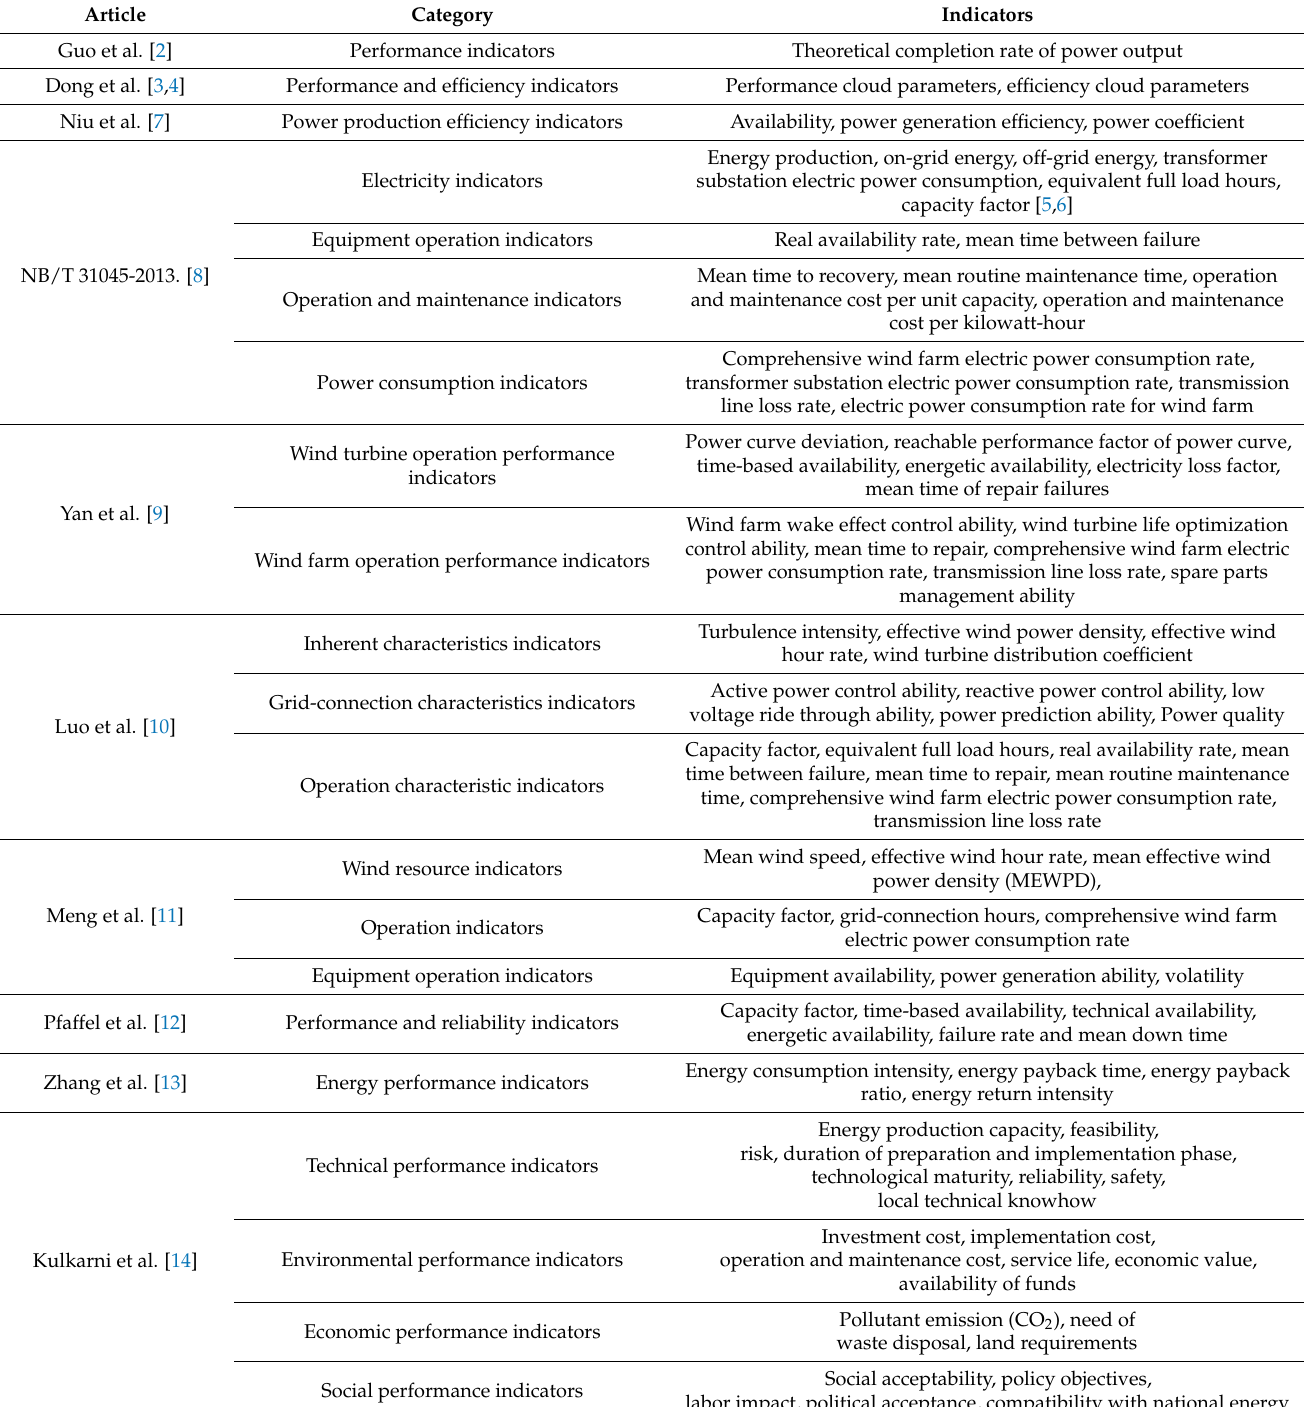
Table 1. The summary of the existing